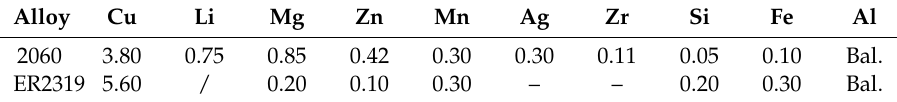
Table 1. Chemical composition of the 2060 Al–Li alloy and ER2319 wire (mass fraction. %). Alloy Cu